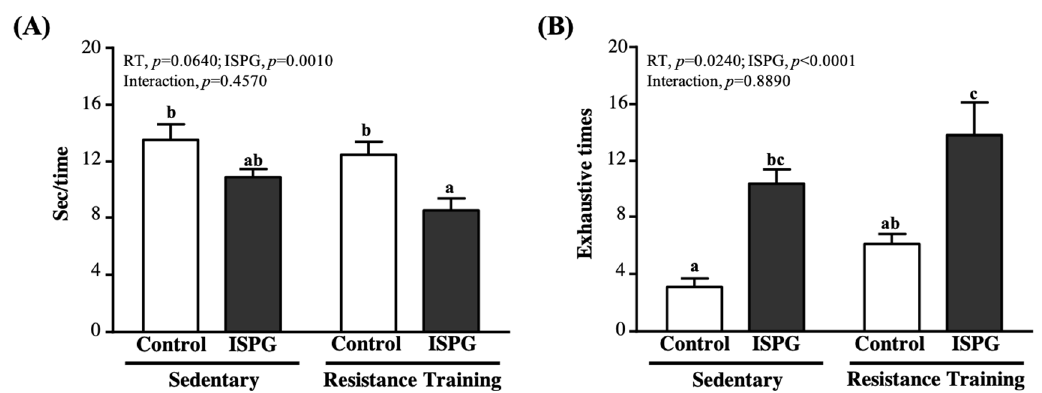
Figure 5. Effect of ISPG and resistance training on ( A ) muscle strength and ( B ) muscular endurance test. Data are expressed as the mean ± SEM of 8 mice/group. Different superscript letters (a, b, c) above the bar are significantly different at p < 0.05. If any letter is the same, it means that the difference between groups is not